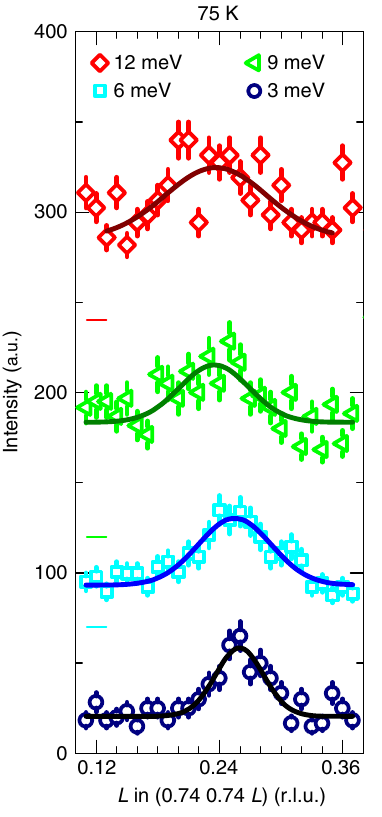
Fig. 5 Magnetic excitations in LaNiO 3 . Inelastic neutron scattering intensities measured at 75 K for 3, 6, 9, and 12 meV energy transfer. The horizontal bars indicate the shift of the data in vertical direction. Up to 12 meV, the magnetic peaks become broader and damped, which is indicative for the appearance of fl uctuations in this itinerant antiferromagnetic system. The intensity error bars are statistical error bars calculated by the square root of intensity